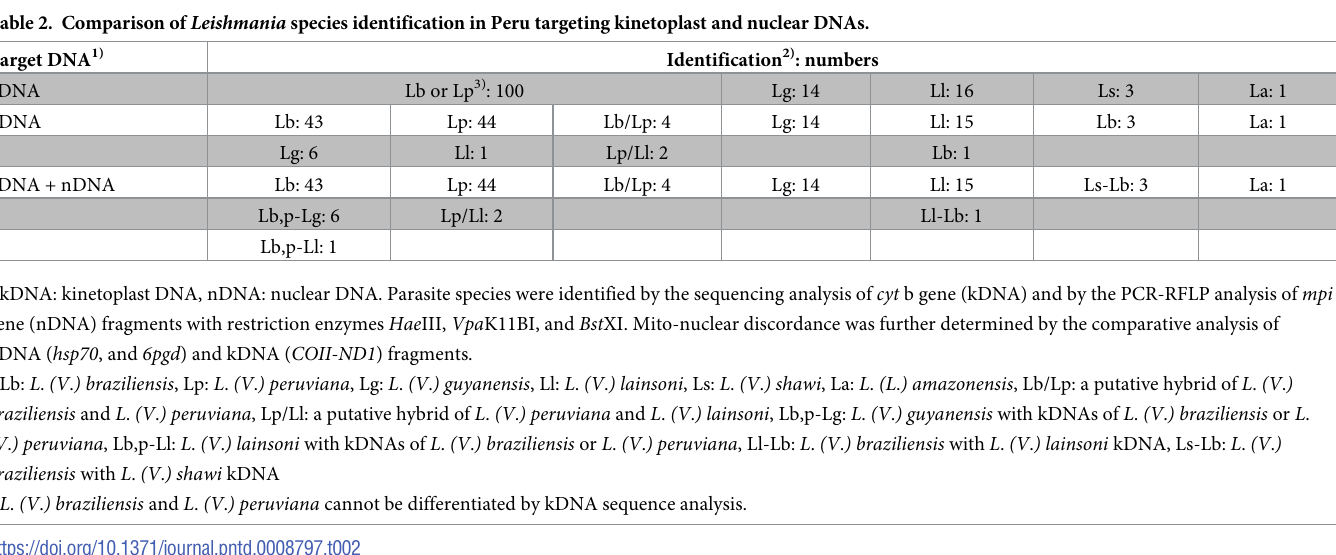
Eleven samples showing discordance between mpi gene and cyt b gene analyses were systemat- ically analyzed using multiple targets including mpi , hsp70 , 6pgd , and COII-ND1 genes to con- firm mito-nuclear discordance (Tables 1 and 2). Sequence analysis confirmed the discordance